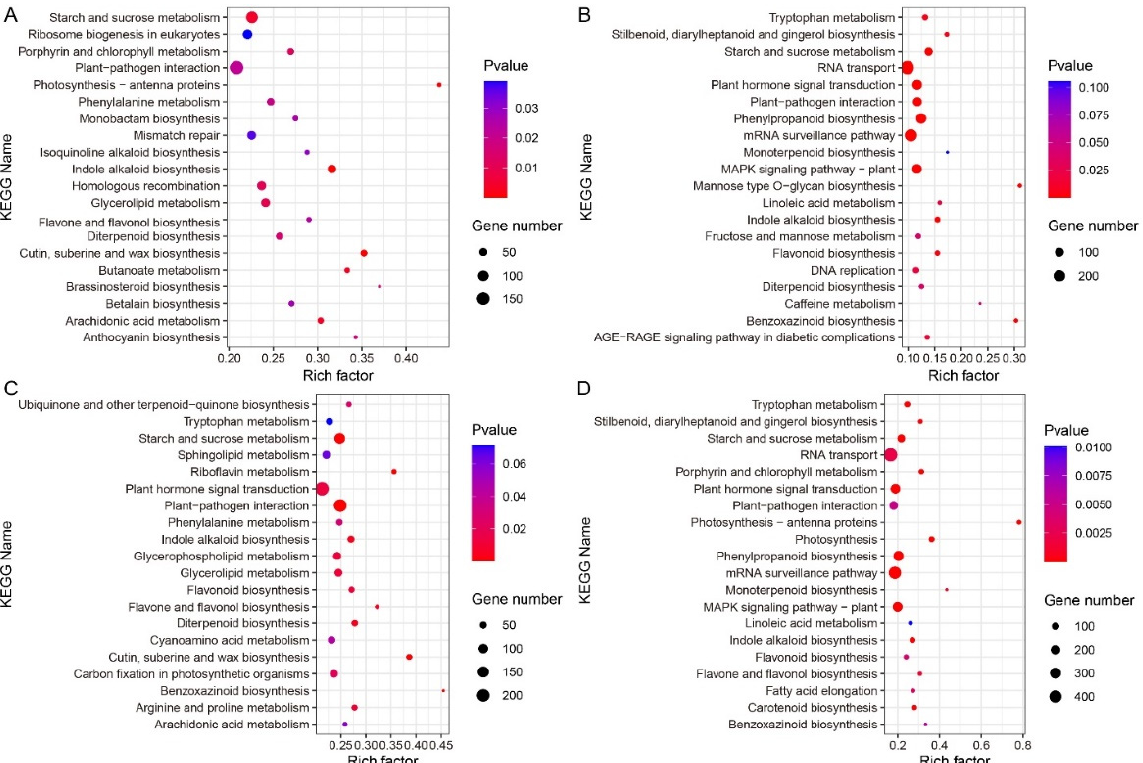
Figure 7. Pathway enrichment analysis of B73 and lpa1 exposed to different treatments. ( A ) B73-CK vs. B73-100; ( B ) B73-CK vs. B73-500; ( C ) lpa1 -CK vs. lpa1 -100; ( D ) lpa1 -CK vs. lpa1 -500. CK = control, 100 = 100 μ mol·L − 1 IAA, and 500 = 500 μ mol·L − 1 IAA.